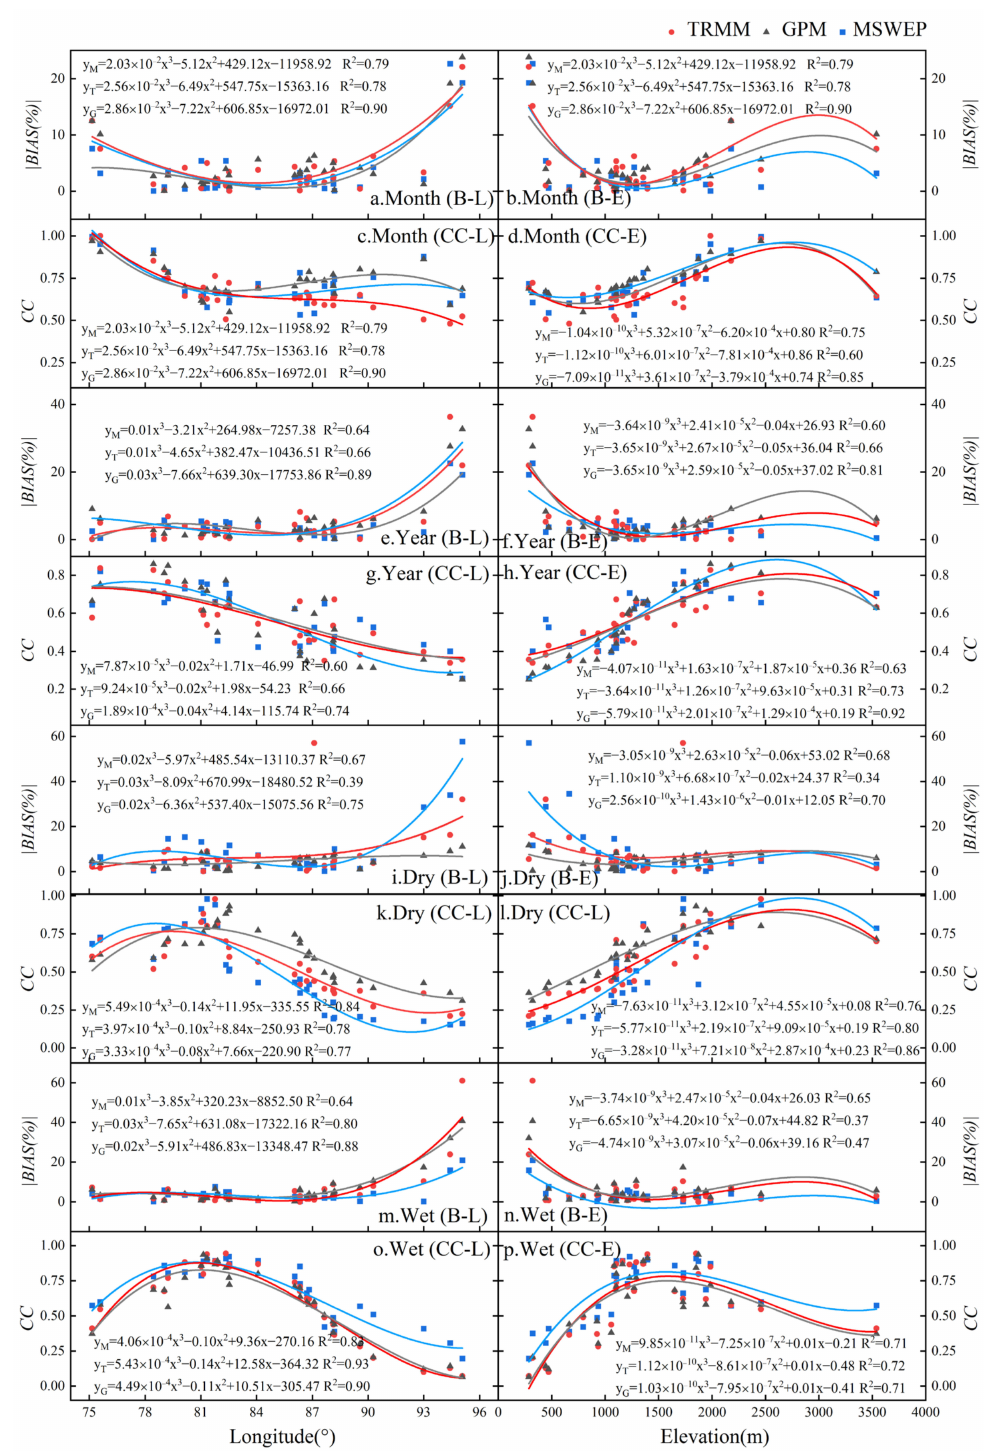
Figure 12. Scatter correlation diagram and fitting lines of monthly, annual, dry and wet season precipitation detection indicators and longitude ( a , c , e , g , i , k , m , o ) and elevation ( b , d , f , h , j , l , n , p ) of the three products. Monthly scale ( a – d ); Annual scale ( e – h ); Dry season ( i – l ); Wet season ( m – p